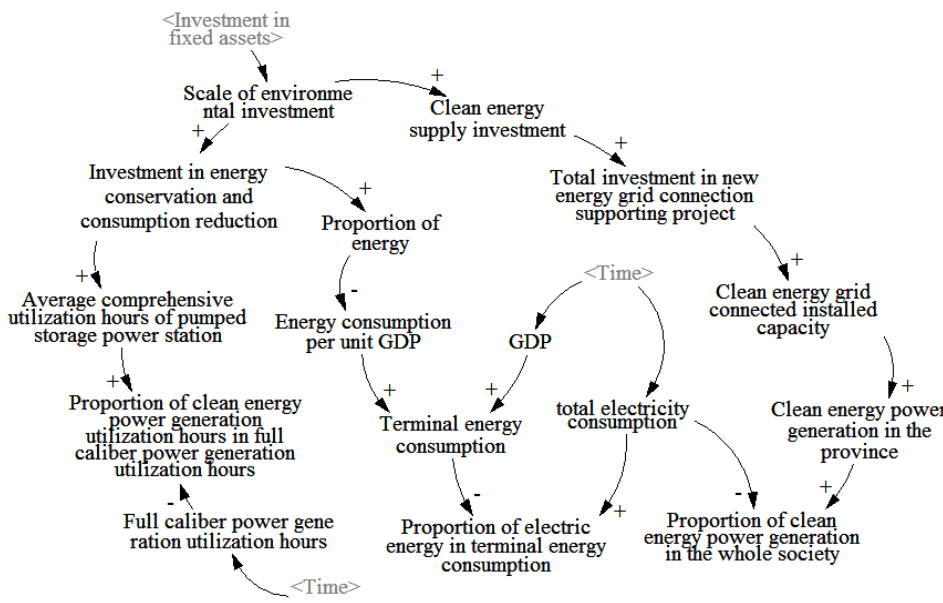
Figure 3. Cause and effect analysis diagram of environmental investment subsystem of grid com- pany .